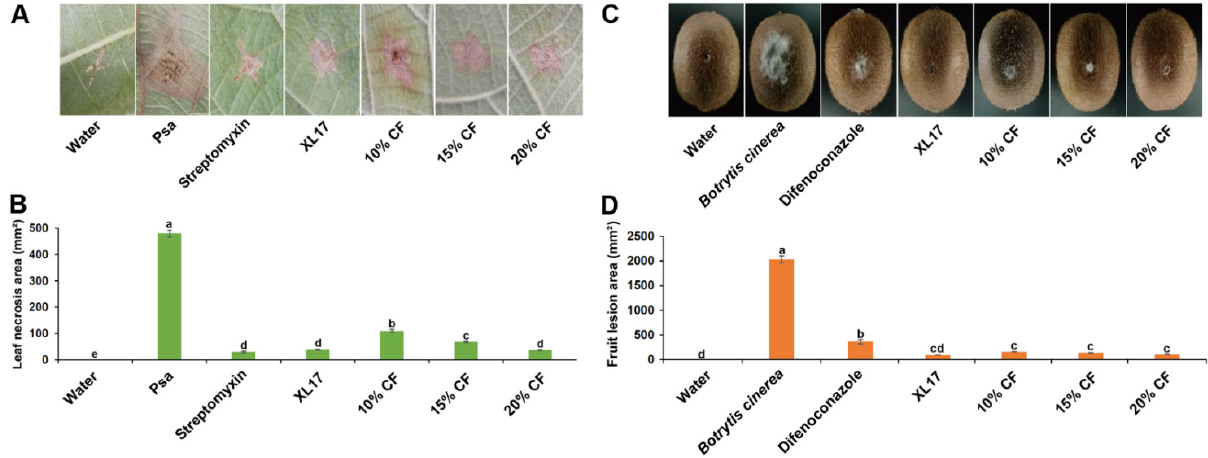
Figure 4. Strain XL17 and culture filtrate (CF) of strain XL17 inhibit necrosis in kiwifruit leaves caused by Pseudomonas syringae pv. actinidiae (Psa) after 10 d of wound inoculation ( A , B ) and lesions in kiwifruits caused by Botrytis cinerea after 7 d of wound inoculation ( C , D ). Leaf necrosis ( A ) caused by Psa under various treatments. Fruit lesions ( C ) caused by B. cinerea under various treatments. Leaf necrosis areas ( B ) and fruit lesion areas ( D ) are mean ± standard error of three replicates for each treatment. Different letters show significant difference at p < 0.05.